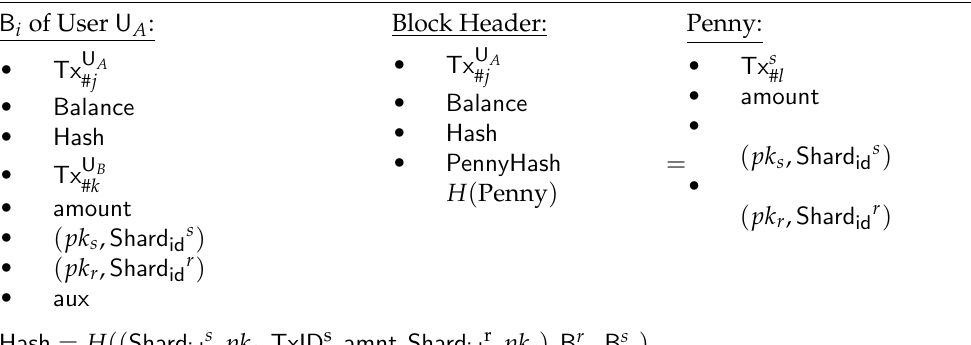
Figure 3. The structure of blocks, headers, and pennies in Dandelion. We let s denote information associated to a sender, while r denotes receiver’s information, l , if either j or k , depending on which of U A or U B is the